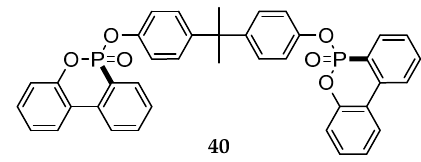
Figure 16. Structure of DOP-Cl 39 .